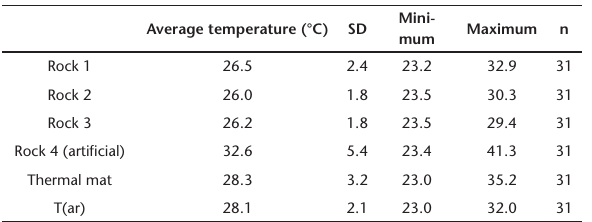
Table 6. Variation in the temperatures of microhabitats observed in the laboratory at the Federal University do Rio Grande do Sul (UFRGS) in January and March 2013.